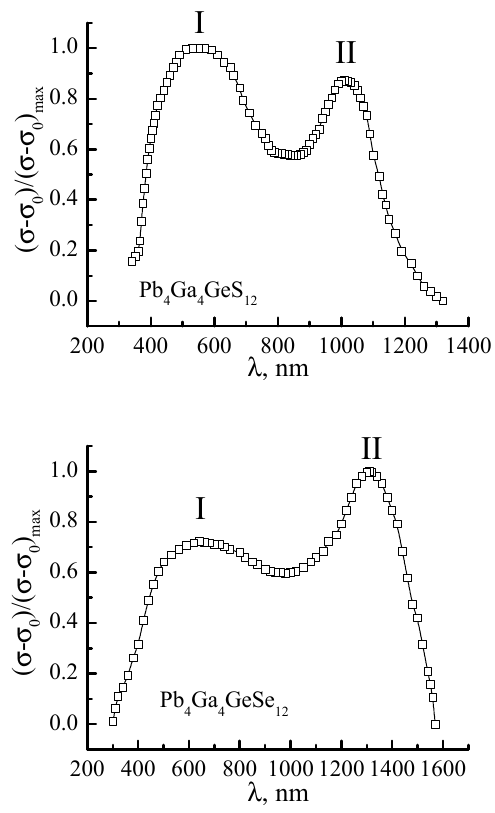
Figure 4. Spectral distribution of photoconductivity for the Pb 4 Ga 4 GeS 12 and Pb 4 Ga 4 GeSe 12